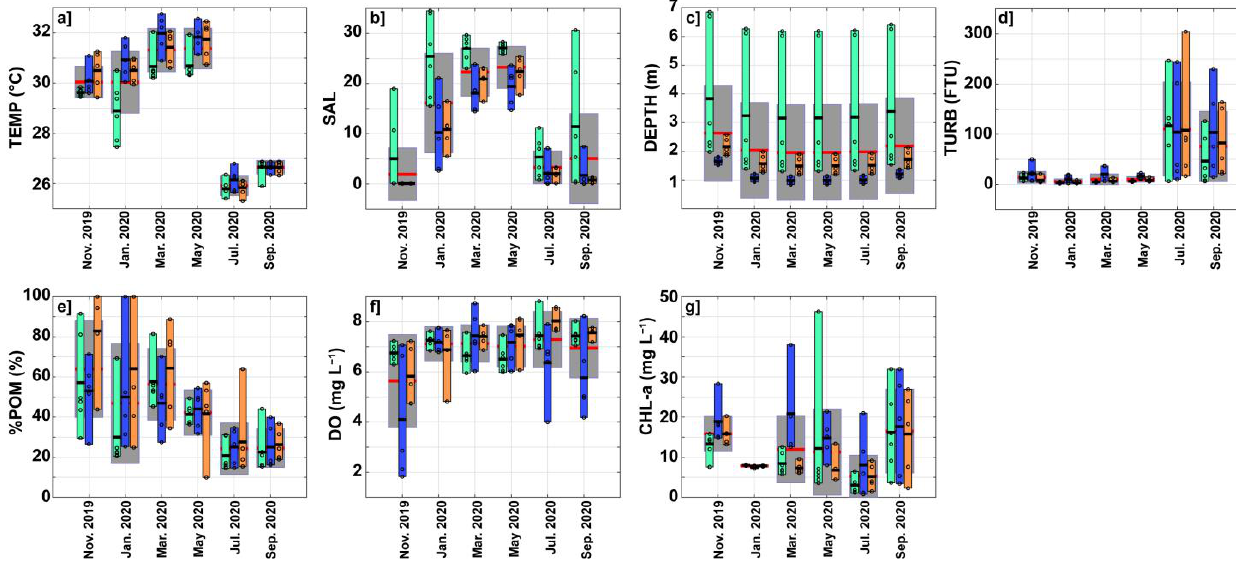
Figure 2. Seasonal variation of environmental parameters for the six bimonthly surveys carried out between November 2019 and September 2020. ( a ) Temperature (TEMP, in °C). ( b ) Salinity (SAL). ( c ) Station depth (DEPTH, in m). ( d ) Turbidity (TURB, in FTU). ( e ) Fraction of particulate organic matter in total suspended material (%POM, in %). ( f ) Dissolved oxygen concentration (DO, in mg L −1 ). ( g ) Chlorophyll-a concentration (CHL-a, in mg L −1 ). On each subplot, the gray bars show the mean value (red horizontal line) +/− one standard deviation for all 16 stations, while the green, blue, and orange vertical bars show the range of data in each sub-region defined in Figure 1b. These colored bars thus extend from the minimum to the maximum value observed in each sub-region, and the black horizontal lines show the mean values of the data indicated by the black circles.